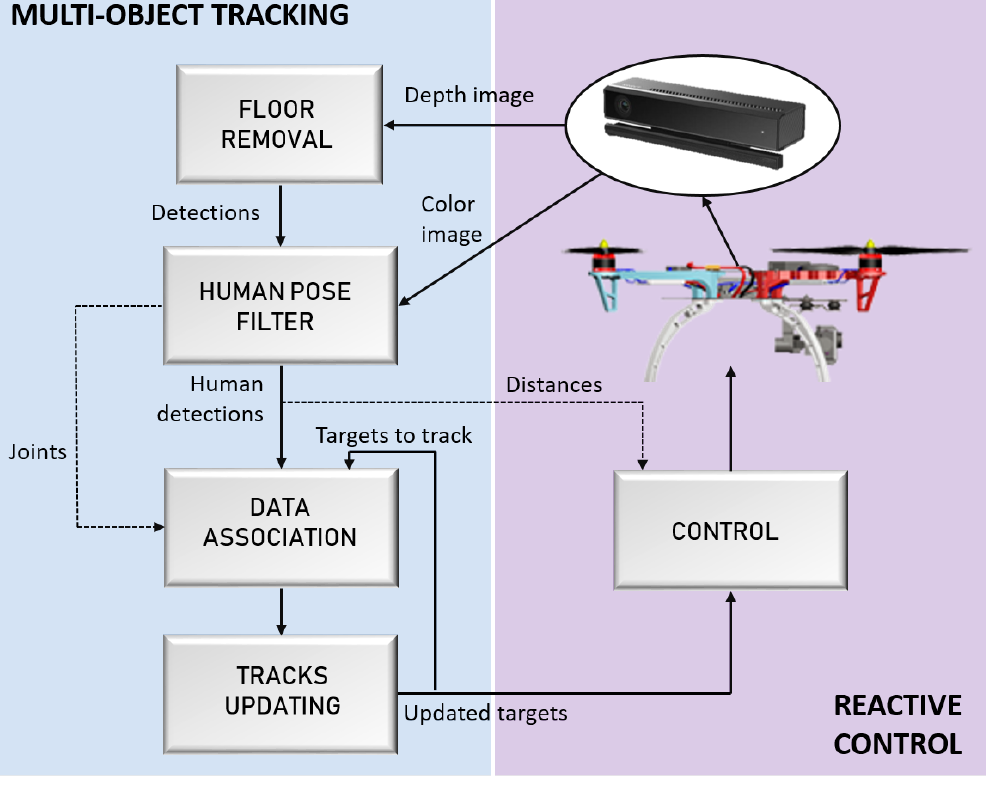
Figure 1. System